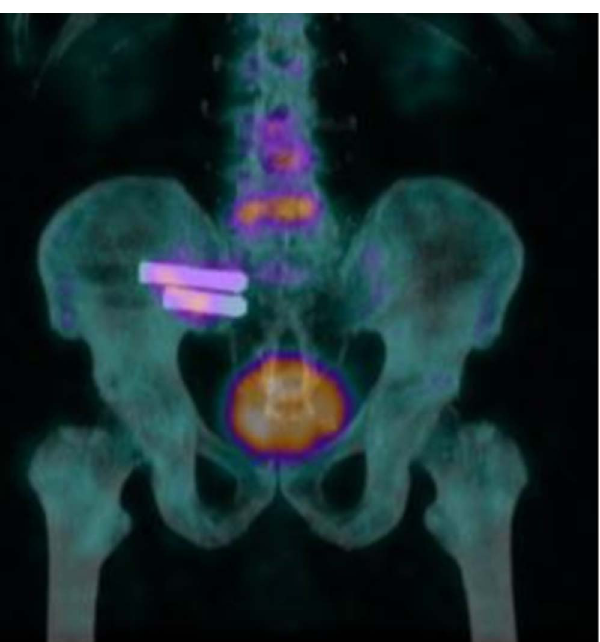
Figure 5. Coronal cut of a SPECT/CT showing cold right SI joint with metalwork insitu and a warm L4 – L5 disc space. The patient later underwent L4 – L5